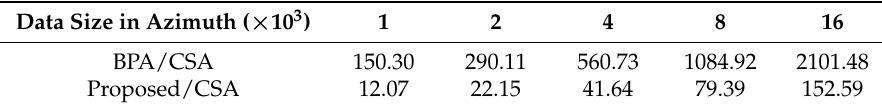
Table 4. Computational load analysis using CSA as